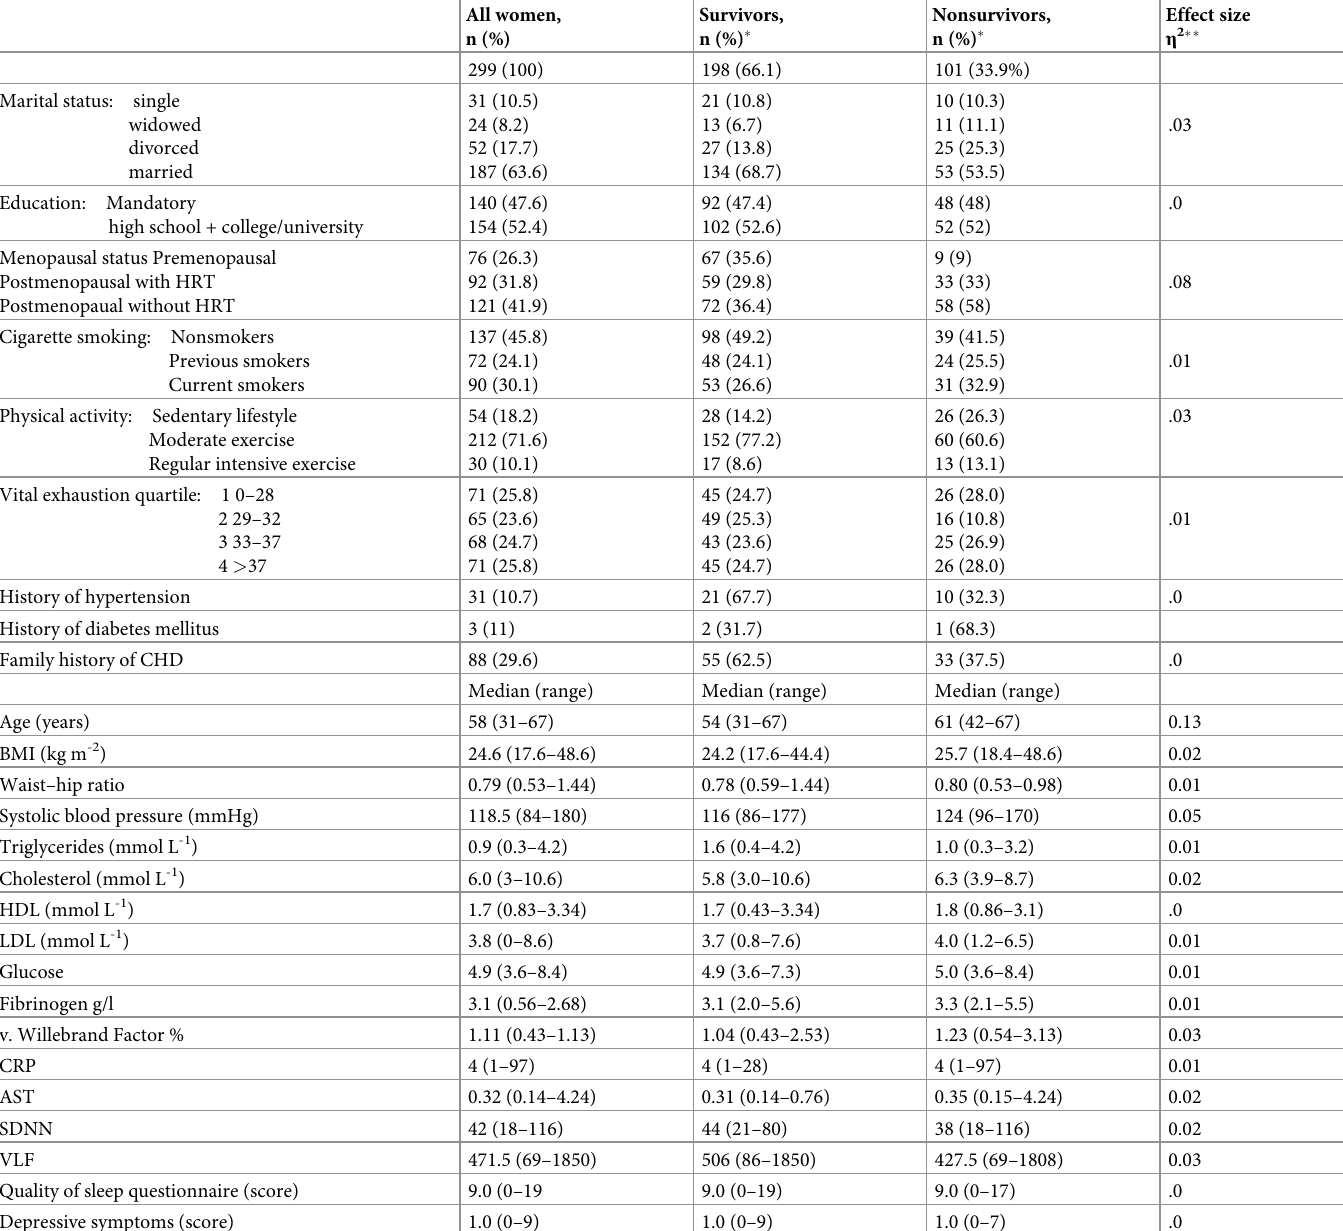
Table 2. Clinical, social and psychological characteristics of 299 healthy women at baseline and survival at 26 years